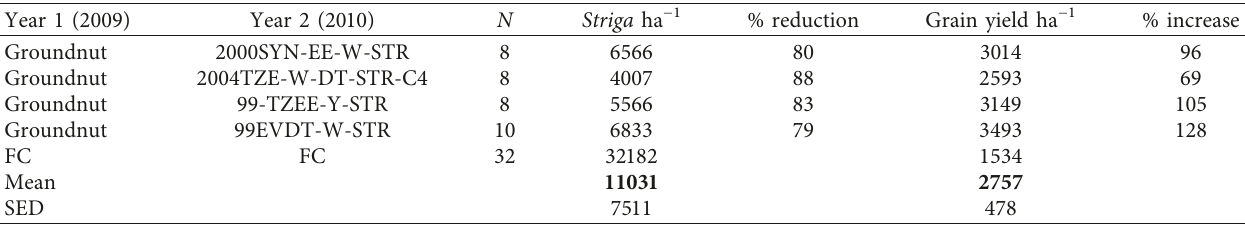
Table 2: Striga count ha − 1 and mean grain yield of different maize varieties following groundnut on farmers’ field in Sudan savannah.